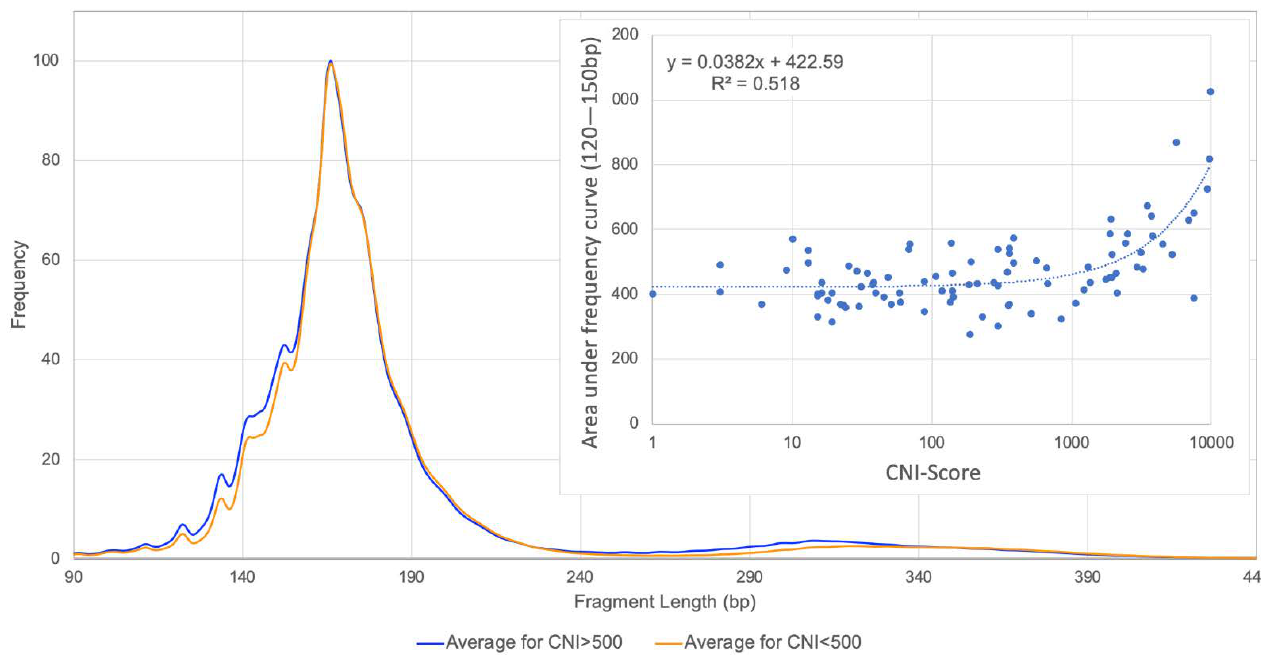
Figure 4. Length distribution of the total cfDNA fragments showed significant differences in samples with CNI-Scores of >500 versus <500 ( t -test, p = 0.00017). The area under the frequency curve between 120 bp and 150 bp was significantly correlated with the CNI-Score levels and, therefore, with the amount of circulating tumor